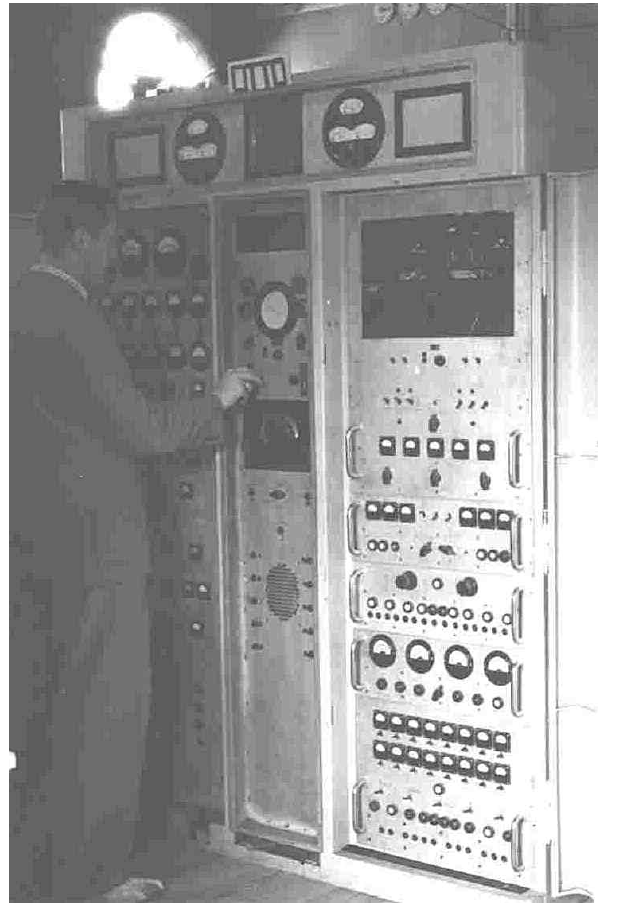
Figure 16. The ionosonde of HHI operating in Juliusruh,